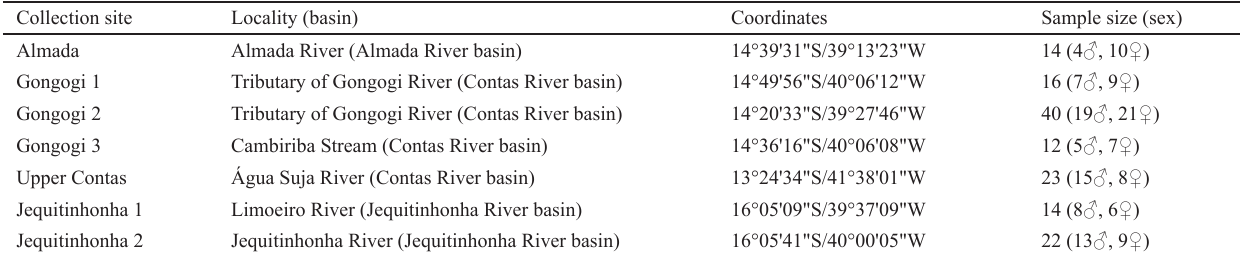
Table 1. Collection sites and sampling of Nematocharax venustus from the Almada, Contas, and Jequitinhonha River basins. ♂ = males and ♀ =